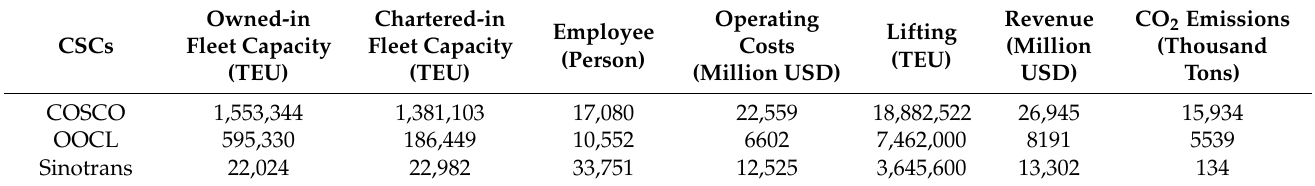
Table A3. Data collection of input and output